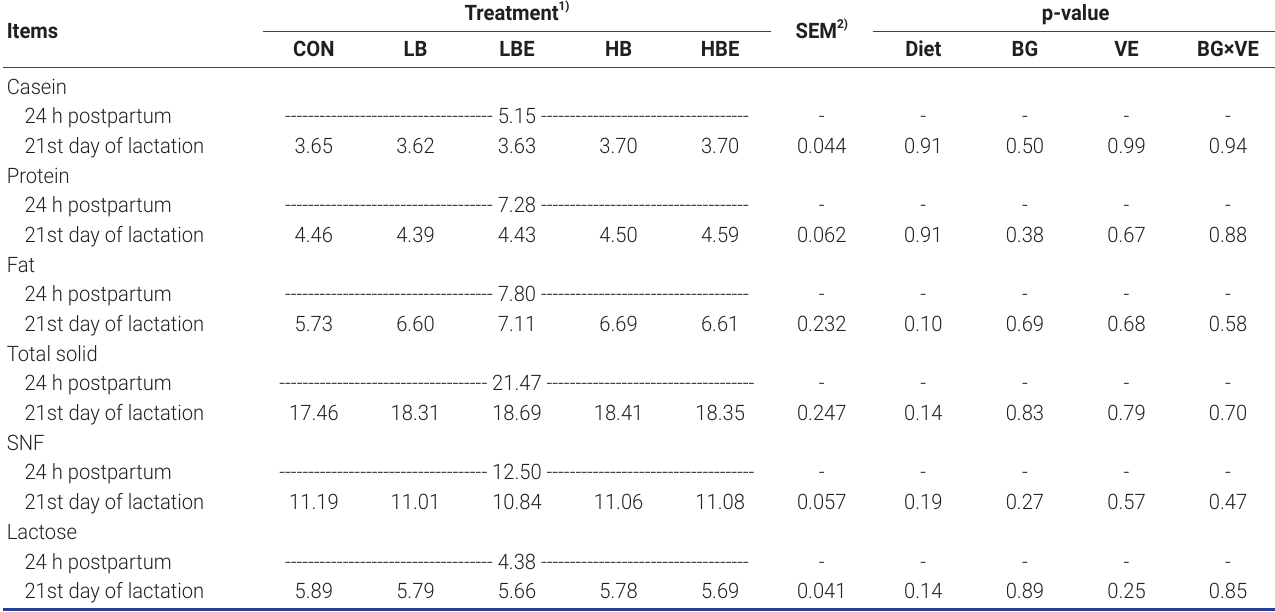
Table 6. Effects of β-glucan with vitamin E supplementation on milk composition in lactating sows